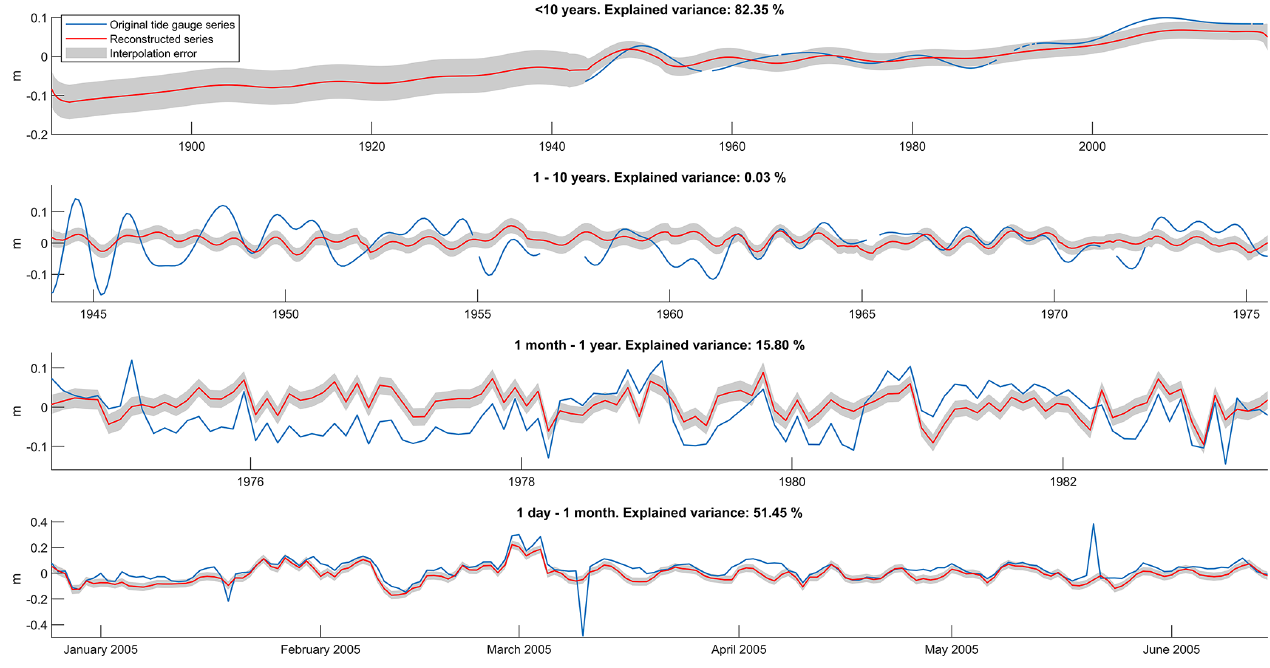
Figure 5. Comparison between the Tarifa tide gauge series and its reconstruction (for the four frequency bands), as given by the cross- validation test. The statistical interpolation error given by the optimal interpolation formulation (Eq. 4) is plotted in the form of an uncertainty for the interpolated values. Different time axes have been used for the different frequency bands in order to correctly appreciate the variability of each